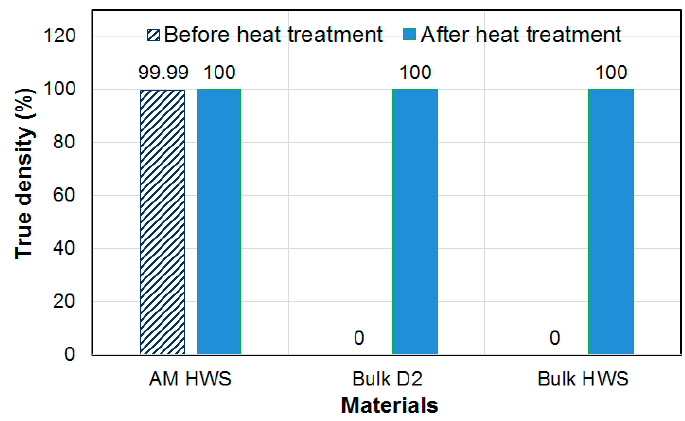
Figure 13. The true density comparison of the three materials.